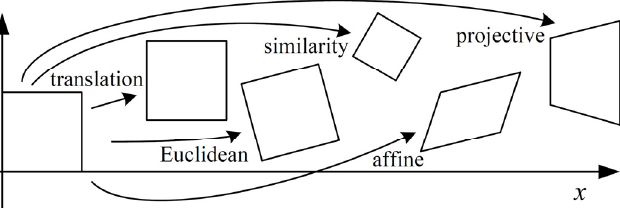
Figure 1. The basic set of 2D planar transformations (Reprinted with permission from Ref. [28]. 2007, now publishers inc).